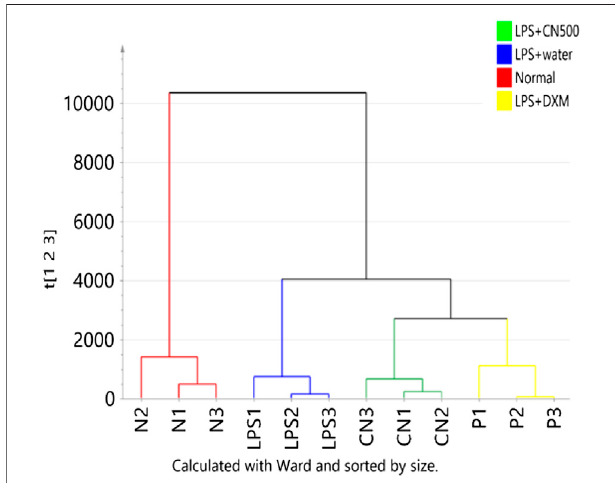
FIGURE2| HCAofthefourgroupsmetabolome(N (cid:2) normal;LPS (cid:2) LPS + water; CN (cid:2) LPS + CN500 and P (cid:2) LPS + DXM; n (cid:2) 3) as classi fi ed by two analytical platforms. Samples are color-coded according to the clustered